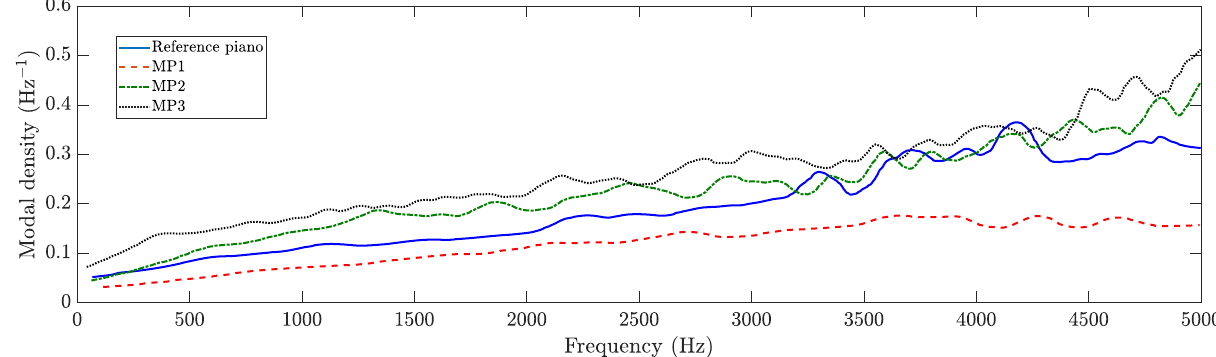
Figure 5. Modal density of the virtual soundboards as a function of the modal